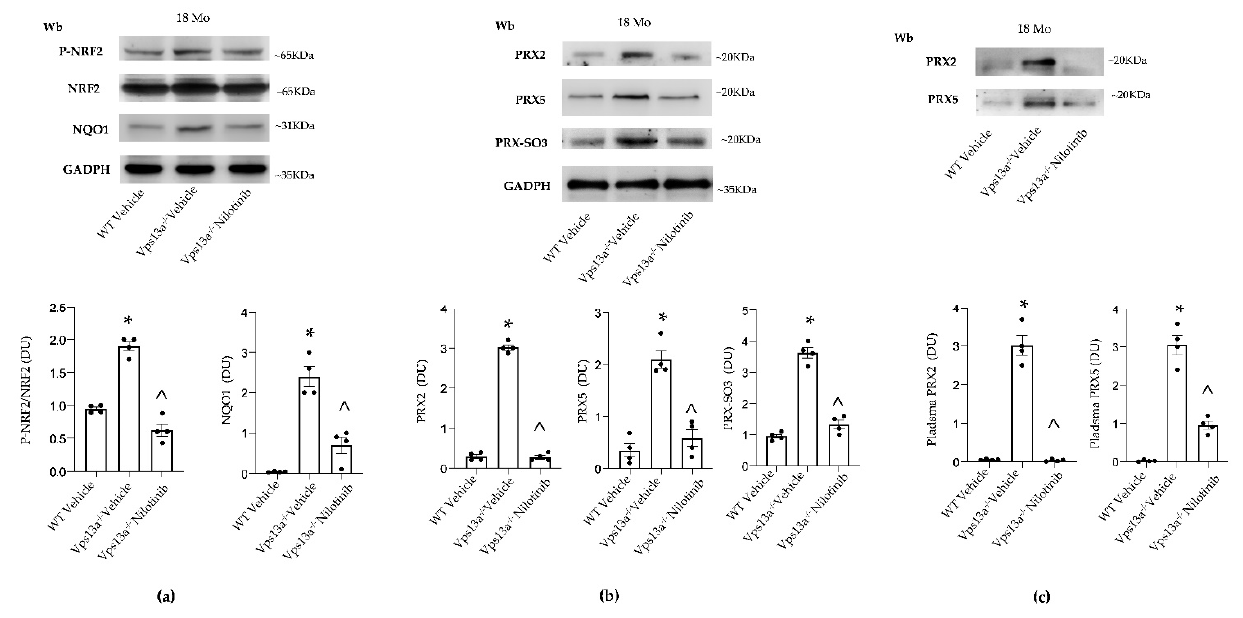
Figure 5. ( a ) Western-blot (Wb) analysis of phospho-NRF2, total NRF2 and NQO1 in isolated basal ganglia of wild-type (WT) and Vps13a − / − mice treated with either vehicle or nilotinib (25 mg/kg/day 6 months) at 18 months (Mo) of age. GADPH was used as loading control. Representative of 4 blots with similar results. Densitometric analysis is shown in lower panel. Data are shown as means ± SEM, n = 4; * p < 0.05 compared to WT animals; ˆ p < 0.05 compared to vehicle treated Vps13a − / − mice. ( b ) Western-blot (Wb) analysis of PRX2, PRX5 and PRX-SO3 in isolated basal ganglia of wild-type (WT) and Vps13a − / − mice treated with either vehicle or nilotinib (25 mg/kg/day for 6 months) at 18 months of age. GADPH was used as protein loading control. Representative of 4 blots with similar results. Densitometric analysis is shown in lower panel. Data are shown as means ± SEM, n = 4; * p < 0.05 compared to WT animals; ˆ p < 0.05 compared to vehicle treated Vps13a − / − mice. ( c ) Western-blot analysis (Wb), using specific antibodies against PRX2 and PRX5, in plasma from WT and Vps13a − / − mice treated with either vehicle or nilotinib (25 mg/kg/day for 6 months) at 18 months of age. Representative of 4 blots with similar results. Densitometric analysis is shown in lower panel. Data are shown as means ± SEM, n = 4; * p < 0.05 compared to WT animals; ^ p < 0.05 compared to vehicle treated Vps13a − / − mice.